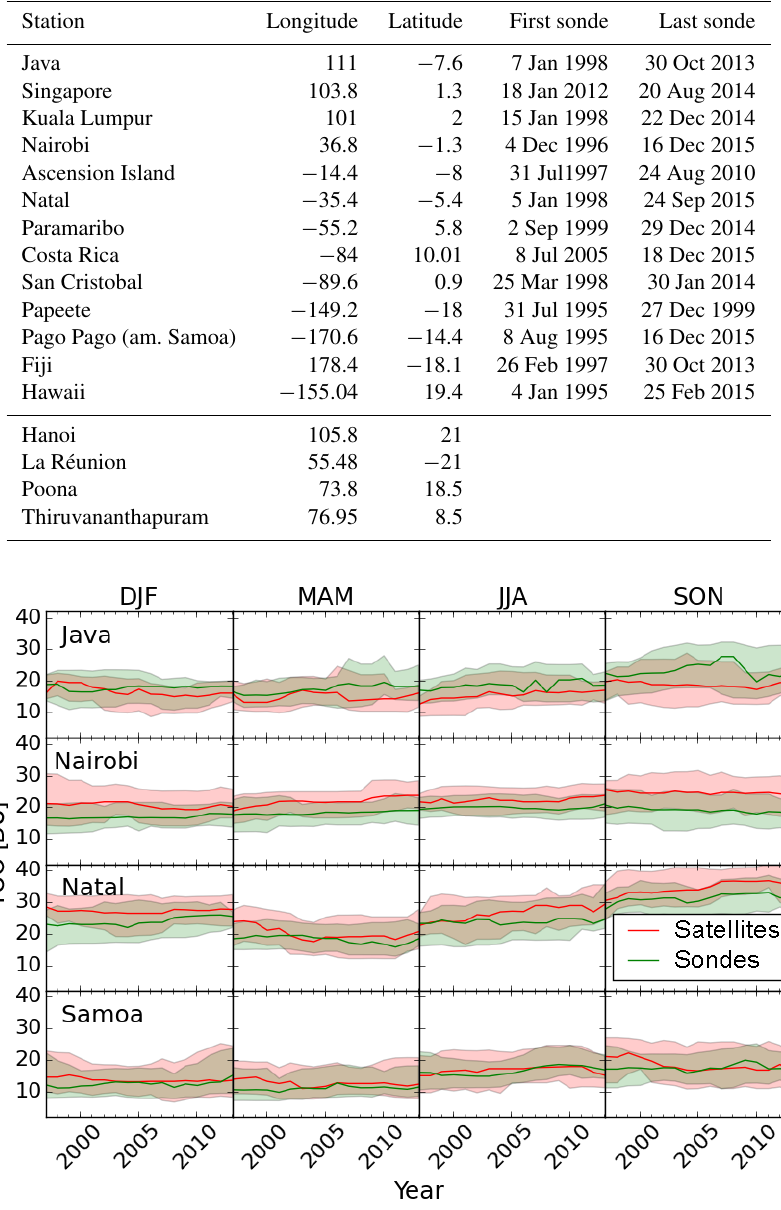
margin the data agree quite well. For the stations Nairobi